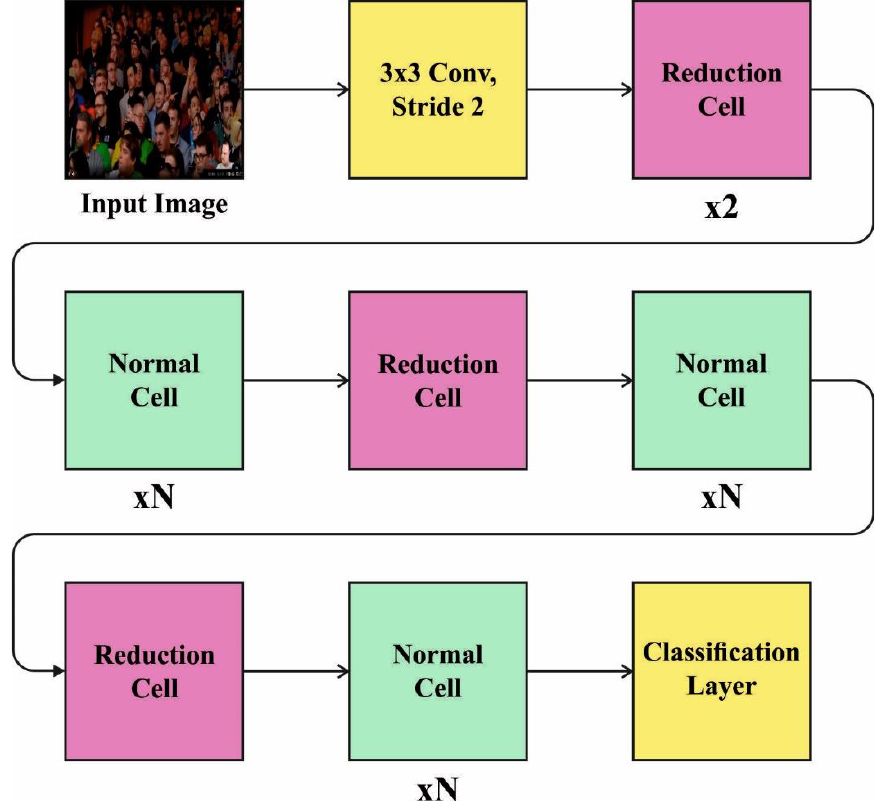
Figure 2. Architecture of